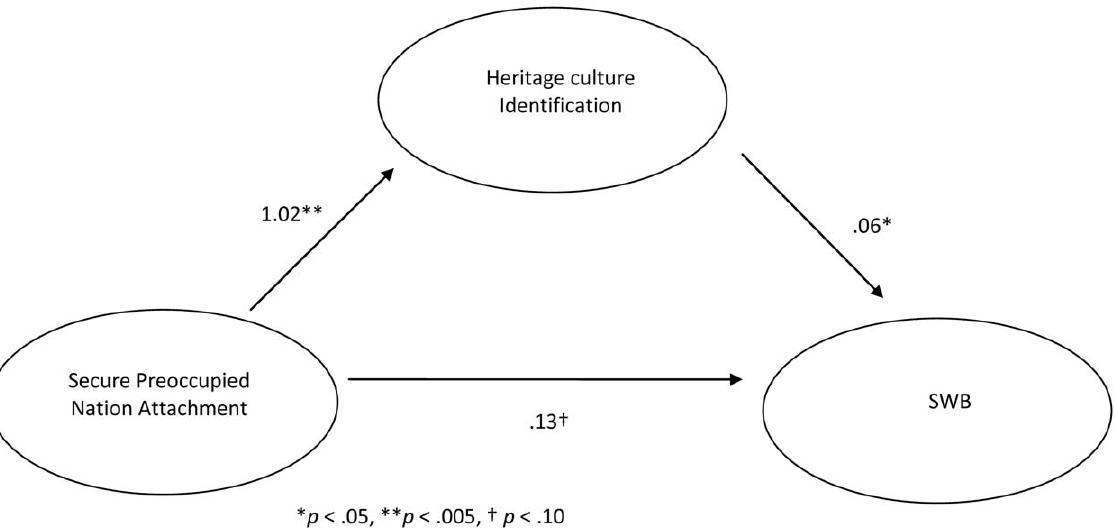
Figure 3. Mediating role of heritage culture identification on the association between secure-preoccupied nation attachment and SWB in Study